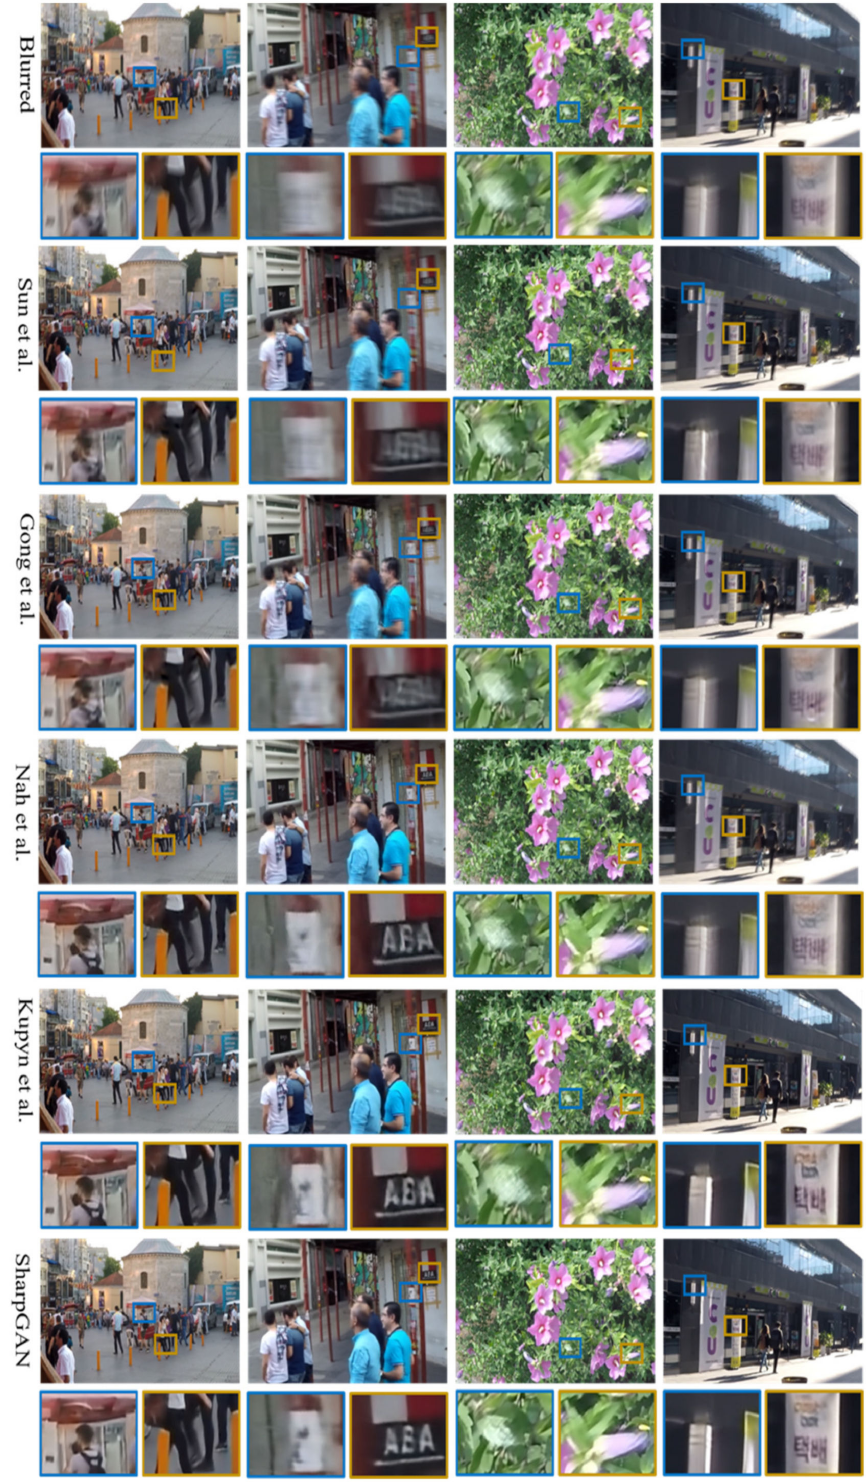
Figure 4. The deblurring results of GOPRO dataset [12]. From top to bottom: blurred images, the results of Sun et al. [10], Gong et al. [13], Nah et al. [12], Kupyn et al. [23], and the results of